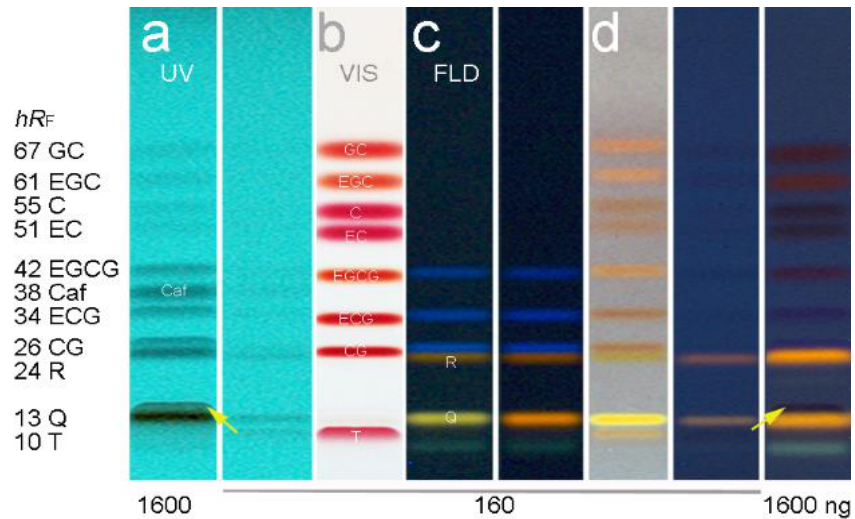
Figure 1. HPTLC–UV/Vis/FLD chromatograms of the developed separation of the 11-bioactive- compound mixture (0.16 and 1.6 µg/band) on the 10 × 10 cm HPTLC plate silica gel 60 RP–18 WF 254 s using acetonitrile–water–citric acid (1.8 mL + 6 mL + 23 mg) at UV 254 nm ( a ), at Vis after derivatization with the Fast Blue B salt reagent ( b ), at FLD via the natural product reagent ( c ), Q turned orange by PEG 400, but of no advantage), and after the reagent sequence of first b then c ( d ); the arrow marks the hR F shift of T for higher T amounts (from below to top of Q, in detail in Figure S2 and Figure S3).